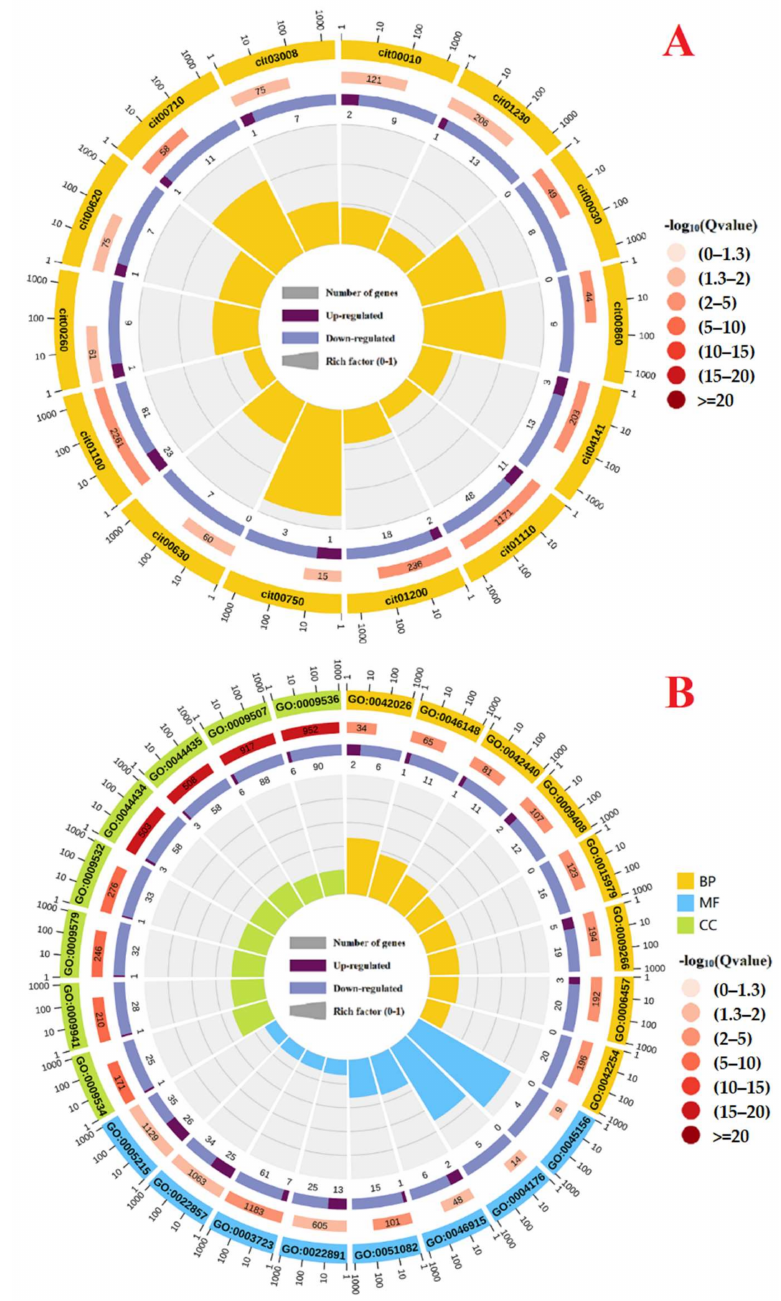
Figure 2. All the significantly enriched 14 KEGG pathways at a corrected p < 0.05 ( A ), and the eight most significantly enriched Gene Ontology (GO) terms in biological process (BP), molecular function (MF), and cellular component (CC), respectively ( B ). The circle from outside to inside is presented as follows: the first circle is the enrichment pathway, and the outside of the circle is the coordinate ruler of the number of genes; the second circle is the number of background genes and the -log10(Qvalue); the third circle is the number of upregulated and downregulated genes; the fourth circle is the rich factor value of each pathway (the number of DEGs in the pathway divided by the number of background genes), and each cell of the background auxiliary line represents